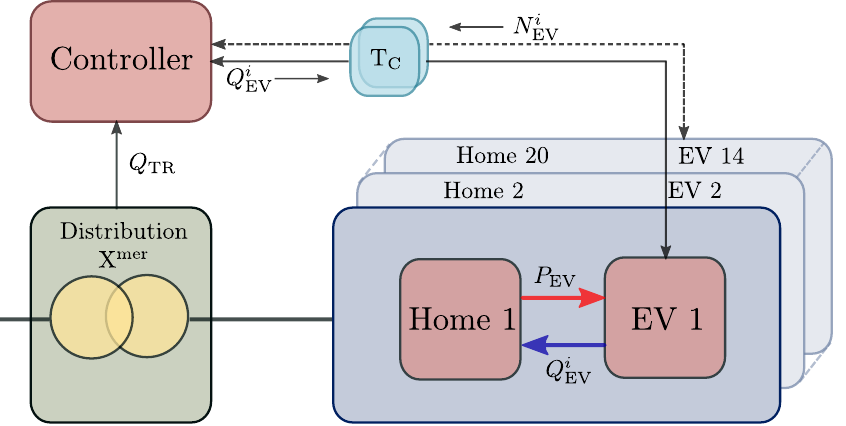
Figure 4. Entire system’s block